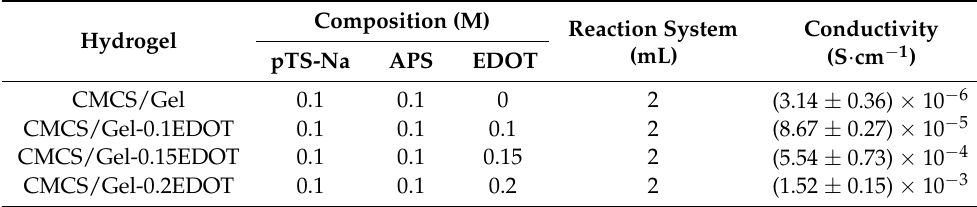
Figure 1. Schematic diagram of the synthesis of CMCS/Gel-PEDOT hydrogels. Table 1. Chemical oxidative polymerization and electrical conductivity of CMCS/Gel-PEDOT hydro- gels with various ratios of EDOT monomer to APS/pTS-Na.